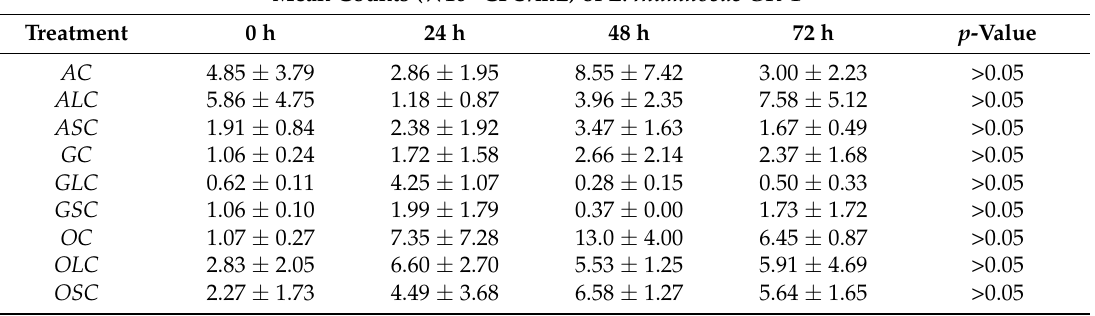
Table 1. Viable counts (Mean ± SD) of L. rhamnosus GR-1 in probiotic non-dairy fruit juices fortified with inulin fiber after 0, 24, 48, and 72 h of fermentation.